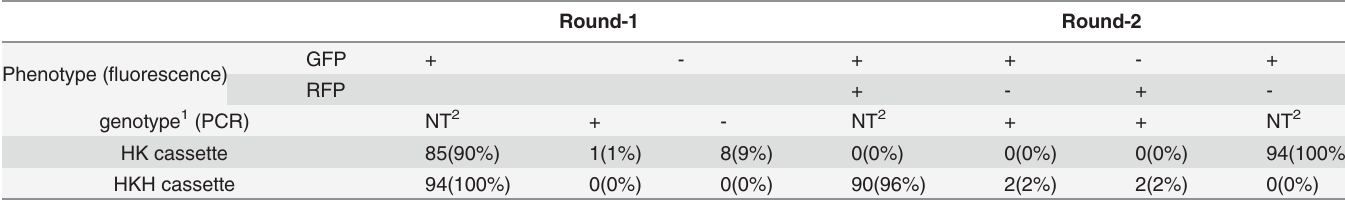
Table 2. Functional and genotype analysis of recombinant pools.